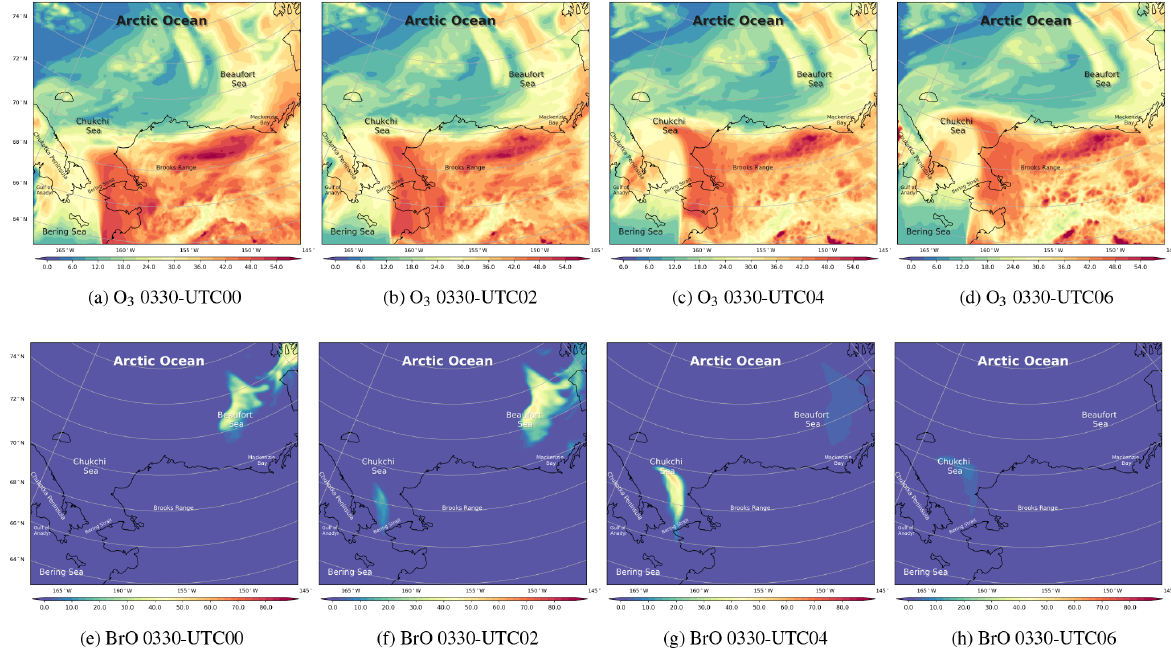
Figure 7. The spatial distribution of the surface ozone (ppb) and BrO (ppt) simulated by CMAQ on 30 March